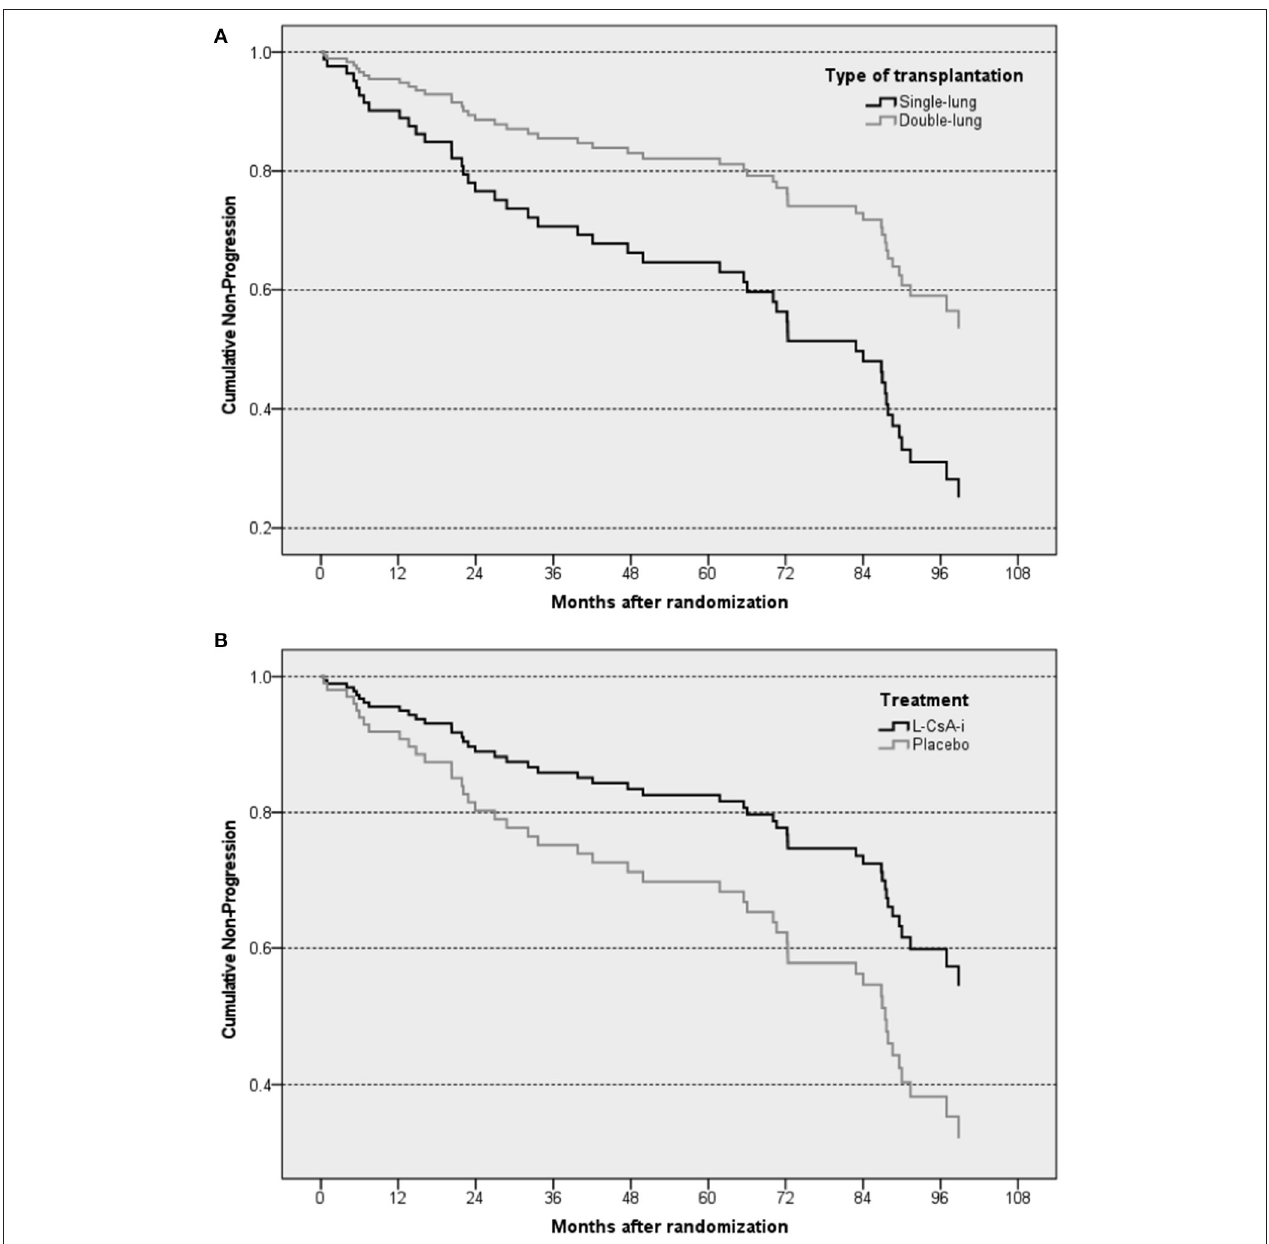
FIGURE 3 | Graphical illustration of estimated cumulative non-progression to a loss in FEV1 by ≥ 20% of the baseline value—Cox regression analysis plotted for type of transplantation (A) and treatment (B) . The “steps” in the curves of the subsets represent predicted events resulting from the regression model.